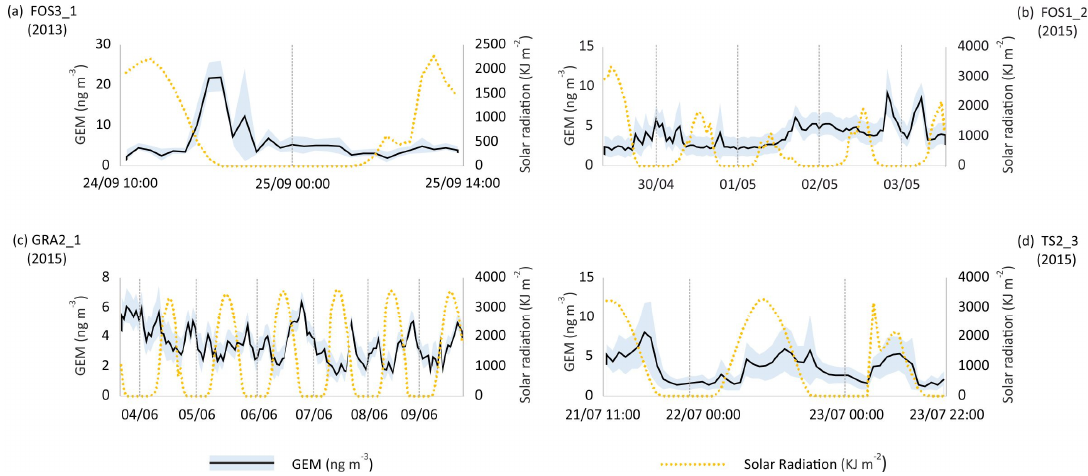
Figure 3. Time-series of GEM (ng m − 3 ) plotted against intensity of solar radiation (kJ m − 2 ) at selected sites. Date is expressed as dd / mm. ( a , b ) Fossalon Hg-contaminated site; ( c ) Grado Hg-contaminated site; ( d ) Trieste urban area.